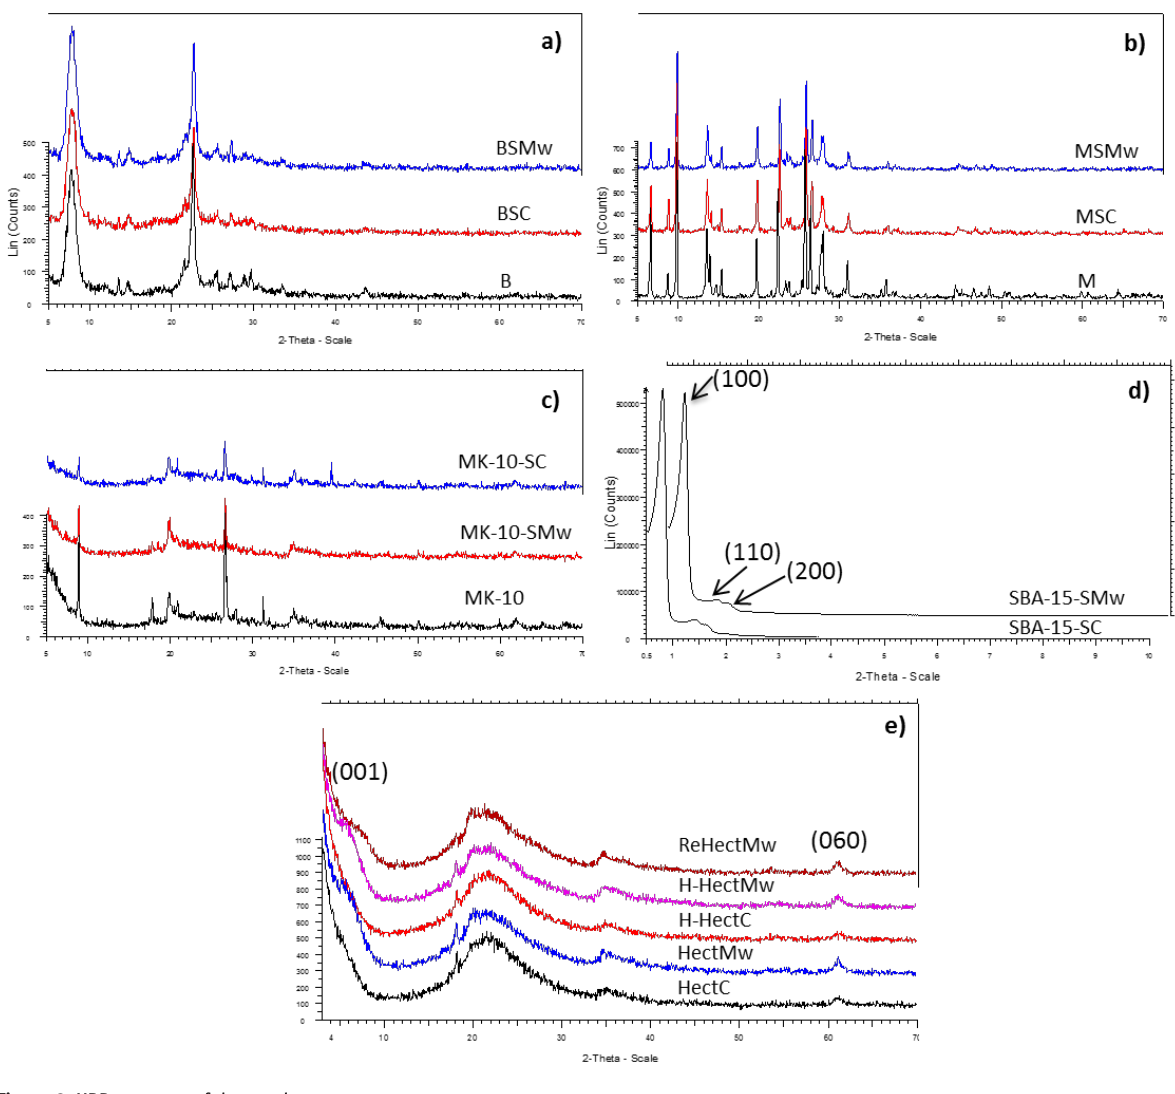
Figure 2 Figure 2: XRD patterns of the